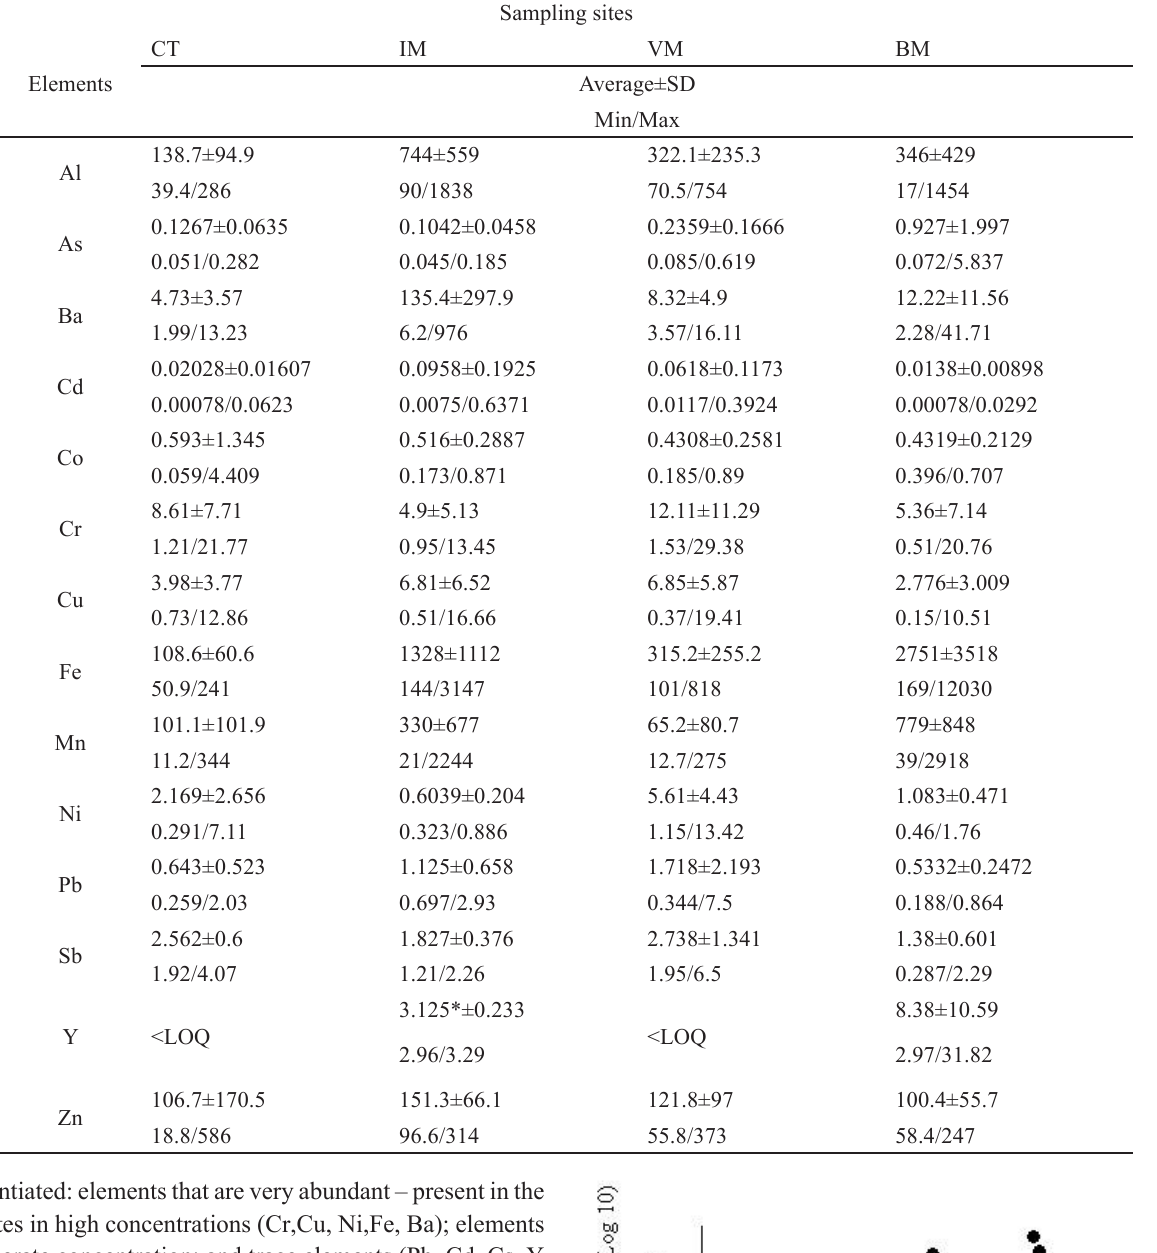
Table 3 . Mineral contents in µg/L for 60 Suspended Particulate Material (SMP) samples collected from four sites in the Iron Quadrangle, MG, Brazil (*) average of concentration no samples with <LOQ. Codes for the areas are as in Figure 1.